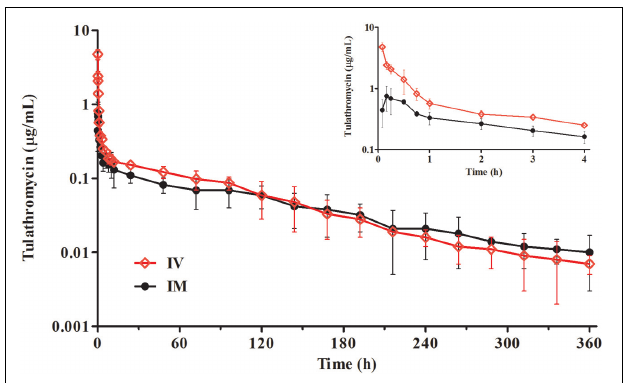
FIGURE 1 | The time–concentration profiles of tulathromycin in porcine serum following a single IV or IM administration of 2.5 mg/kg ( n = 8).